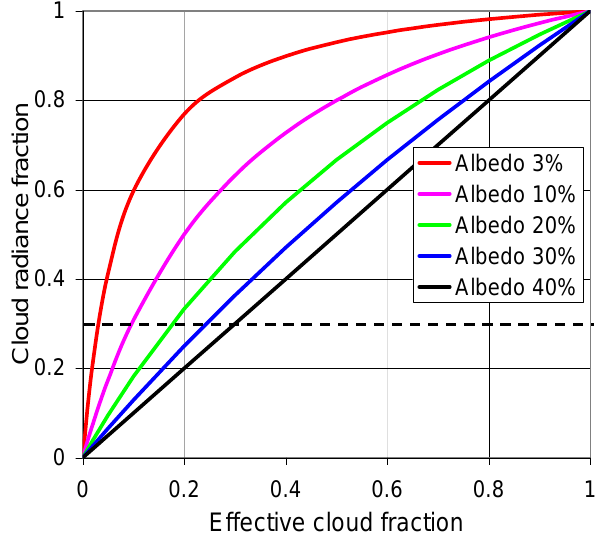
Fig. 1. Dependence of the CRF on the effective cloud fraction for different values of the surface albedo (see also Fig. 2). The black dotted line indicates a CRF of 30%, which is used as threshold value for the CO measurements from SCIAMACHY in this study.